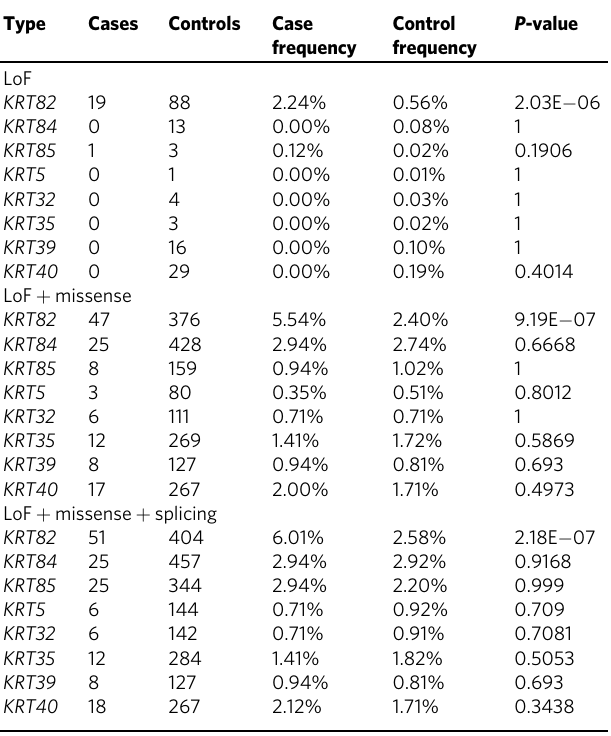
Table 3 Signi fi cant AA-associated variation is speci fi c to KRT82 in comparison to seven other keratin genes including four type I keratins ( KRT32, KRT35, KRT39, KRT40 ), two type II hair keratins ( KRT84, KRT85 ), and one type II epithelial keratin ( KRT5